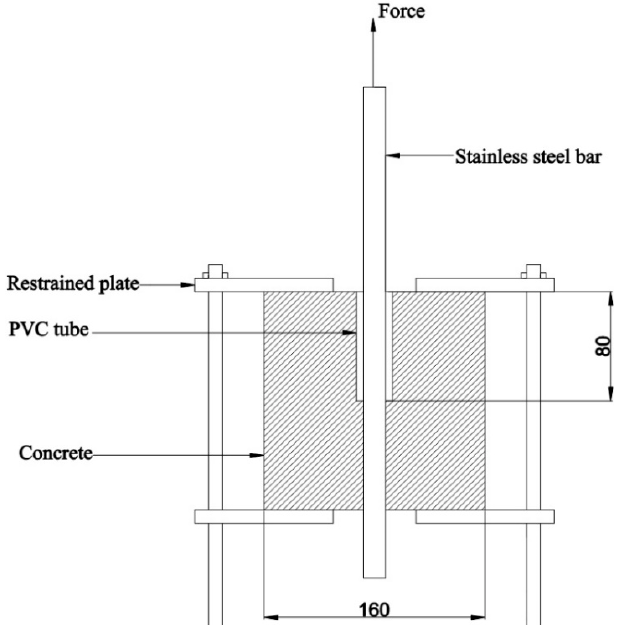
Figure 3. Schematic diagram of the center pull-out test piece